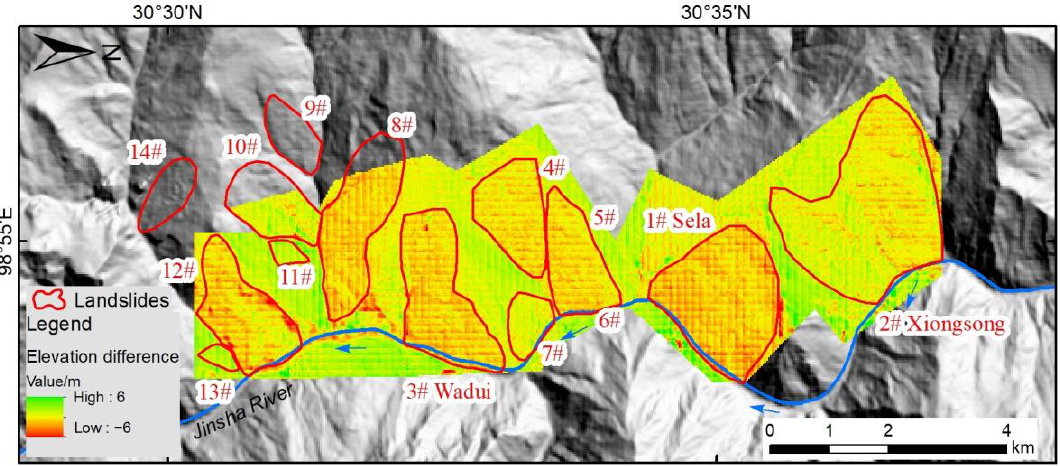
Figure 9. The elevation difference between SRTM DEM and DSM obtained from UAV images. Different numbers labeled the landslide.